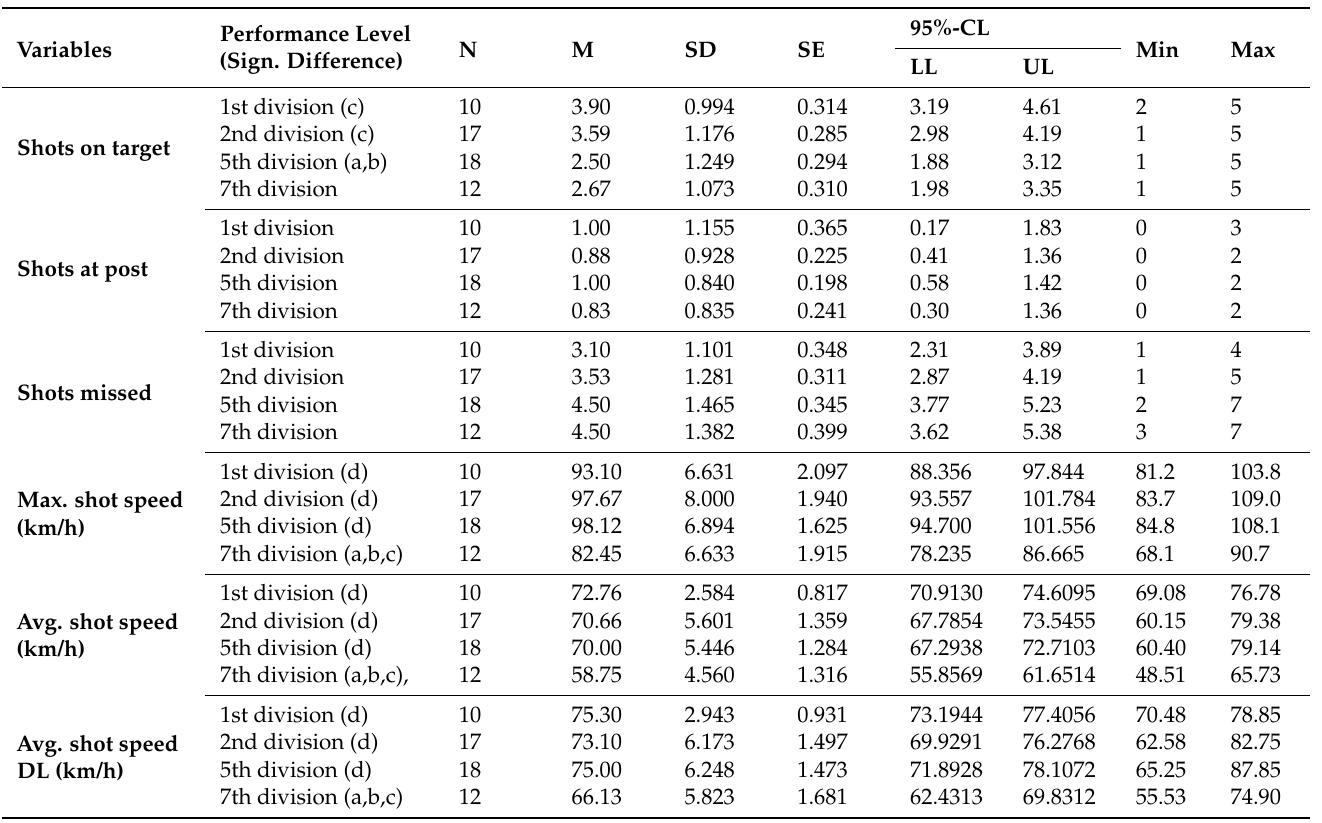
Table 1. Descriptive statistics with noted significant differences between performance levels shown through the post hoc